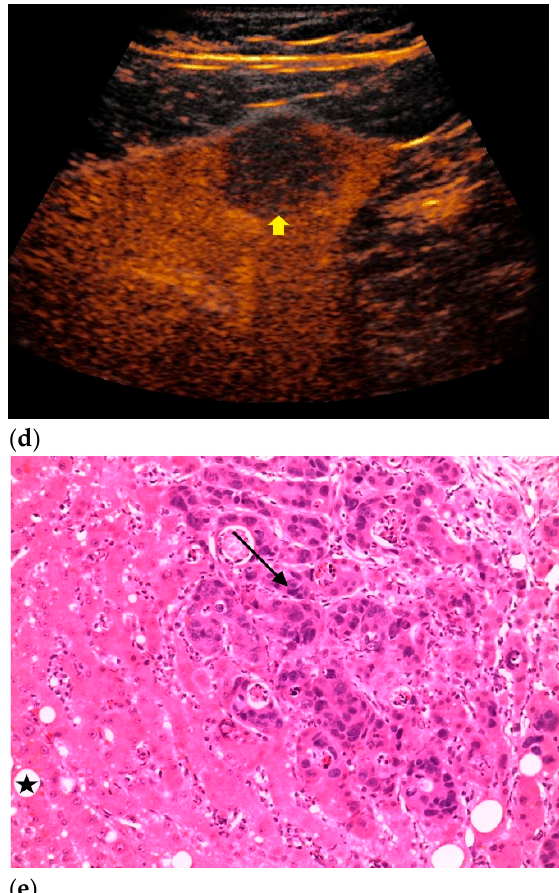
Figure 4. Sonomorphological features of a suspicious liver lesion in CEUS. Subsequent biopsy with histopathological assessment revealed colorectal cancer metastasis. ( a ) An inhomogeneous, slightly hyperechoic liver lesion is visualized in native B-mode (yellow arrow). ( b ) The lesion appears hypervascularized in Doppler mode (yellow arrow). ( c ) In CEUS, rapid and homogeneous contrast enhancement was registered in the arterial phase (yellow arrow). ( d ) In the venous phase, the lesion showed homogeneous wash-out compared to the liver parenchyma (yellow arrow). ( e ) Hematoxylin and Eosin staining of the lesion, 20× magnification. Colorectal adenocarcinoma metastasis is shown on the right (black arrow), normal liver tissue is shown on the left with concomitant steatosis (black star).